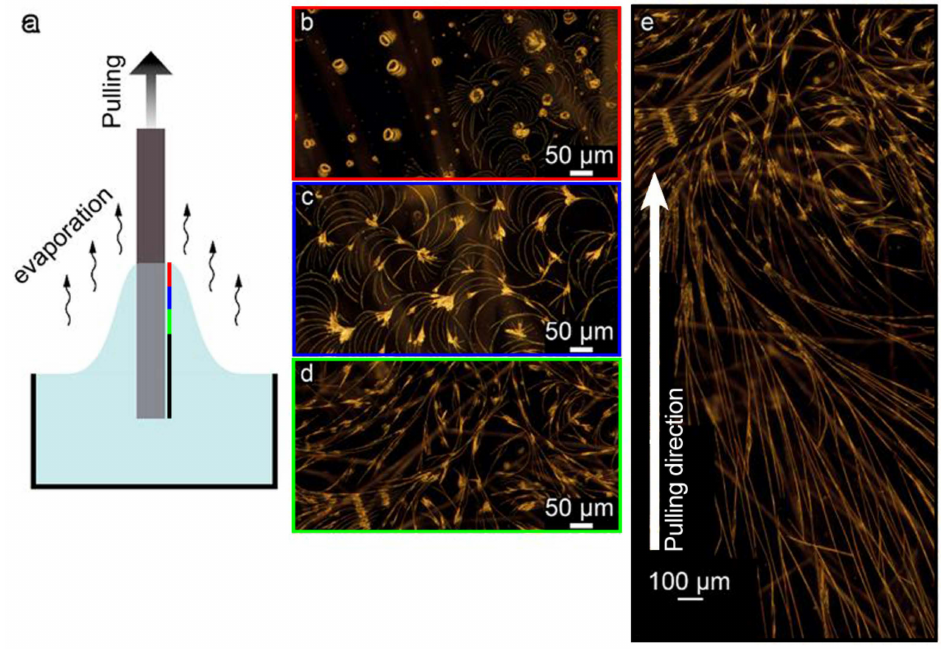
Figure 1. FF microstructures fabrication by the dip-coating method: ( a ) schematic of the pro- cess; ( b – d ) optical dark-field images of the microstructures formed at the beginning of the process; ( e ) microstructures transformation from disordered crystals to quasi-regular elongated belts. Color frames indicate the position at the substrate where the image was taken relative to the meniscus (see the color bar in ( a )). All images are taken for the same sample orientation as it was pulled out. The white arrow in ( e ) shows the pulling